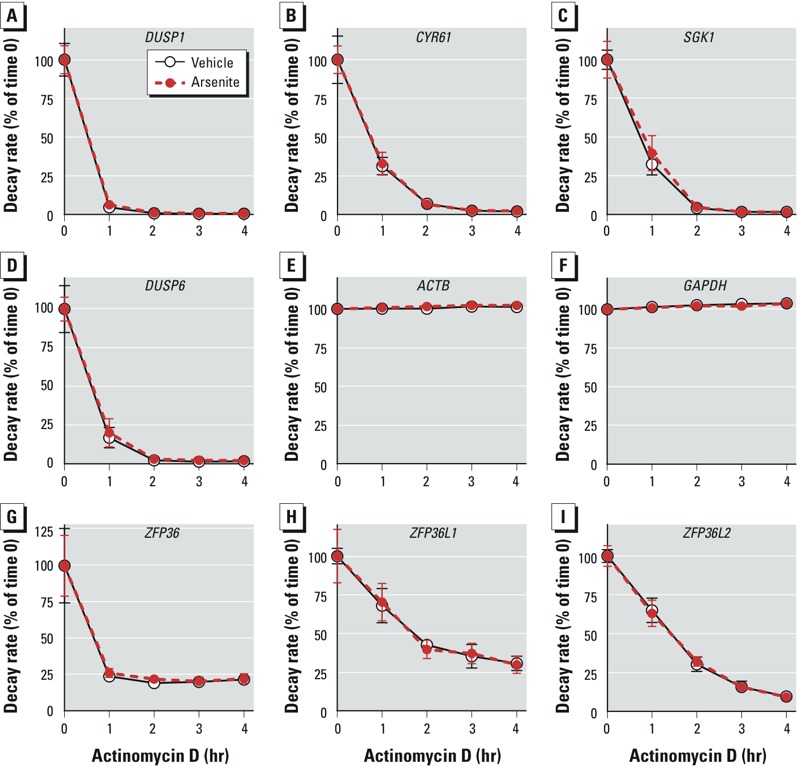
Decay rates of selected probe set–identified transcripts measured by microarray in cells treated with vehicle or arsenite for 24 hr and then treated with actinomycin D. Probe set–identified transcript levels were determined before and at 1 hr intervals after actinomycin D treatment. The starting levels of each probe set–identified transcript after 24 hr of treatment but before actinomycin D were set at 100%, and data are expressed as mean percentages (± SD) of the average starting value (n = 4 biological replicates per group). Decay curves for vehicle- and arsenite- treated cells are shown for the four most rapidly decaying probe set–identified transcripts (A–D); two expected to be stable under these conditions, encoding GAPDH and ACTB (E,F); and three encoding the TTP family members expressed in human cells, ZFP36 (TTP; G), ZFP36L1 (H), and ZFP36L2 (I). In these examples, there were no differences between the decay rates between arsenite- and vehicle-treated cells. The Affymetrix probe set identifiers for the transcripts shown in this figure are as follows: DUSP1, 201041_s_at; CYR61, 210764_s_at; SGK1, 201739_at; DUSP6, 208892_s_at; ACTB, 224594_x_at; GAPDH, 213453_x_at; ZFP36, 201531_at; ZFP36L1, 211962_s_at; and ZFP36L2, 201368_at.